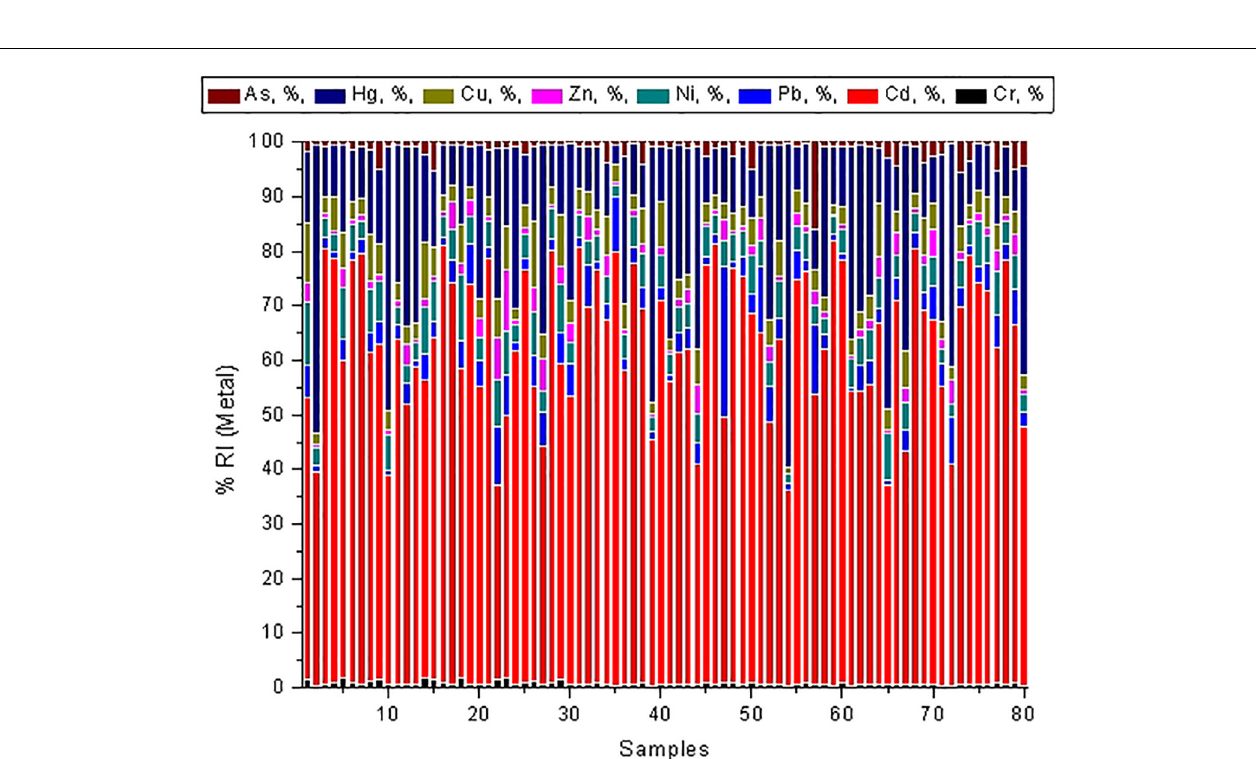
FIGURE 8 | The individual contribution of metals to RI in the studied soil samples.